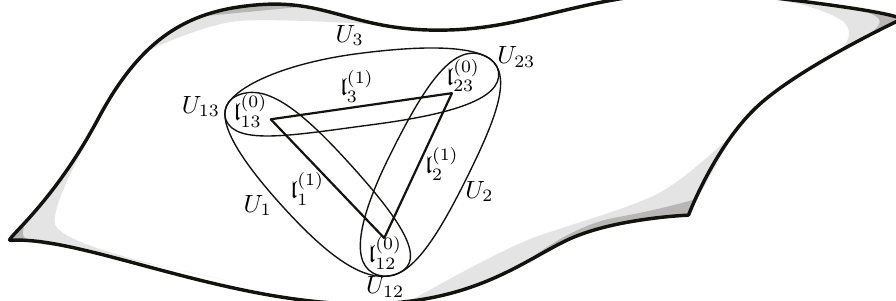
subordinate to a choice of l (1) i =1 i